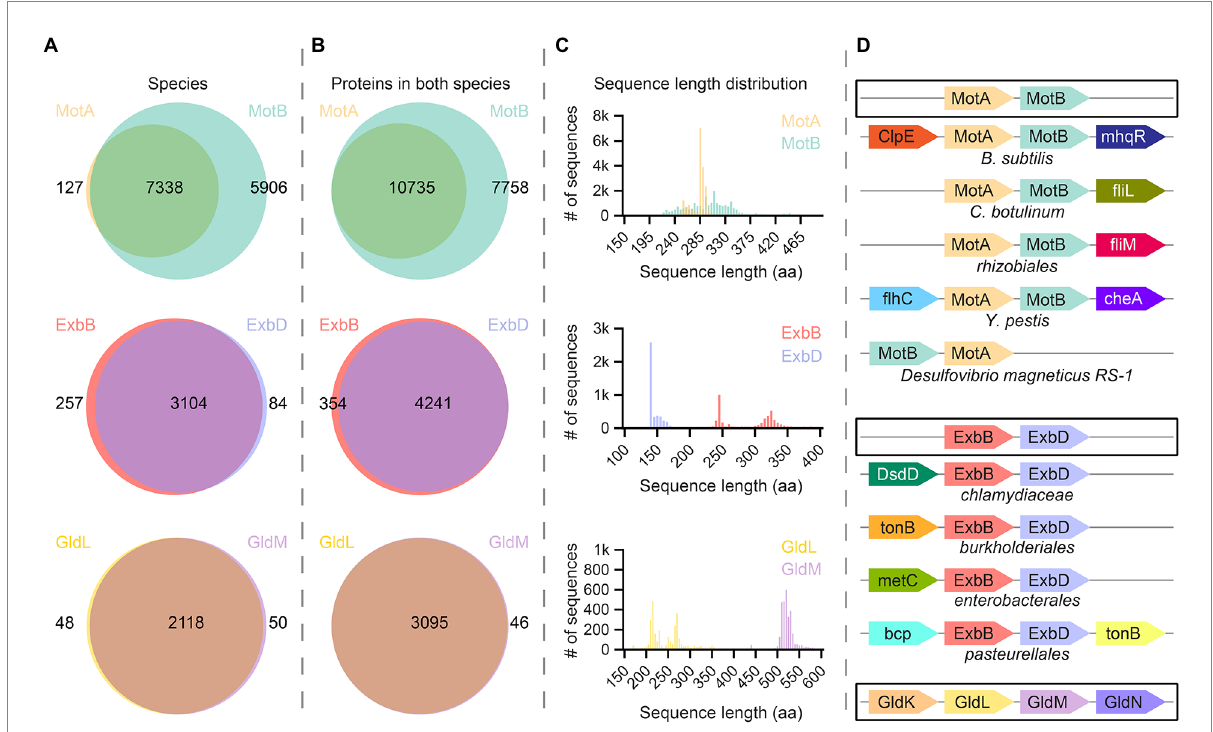
FIGURE 5 Bioinformatic analysis of bacterial proteins in the MotA/MotB family. (A) UniProt database were systematically screened for species that contain the MotA, MotB, ExbB, ExbD, GldL, or GldM proteins. In most cases, species contain annotations for both the transmembrane-barrel component and the rotational-axis component of a protein pair. (B) We analyzed the number of proteins in species that contain two elements of molecular motors [overlapping in (A) ]. The number of annotated ExbB/D and GldL/M proteins is rather similar, whereas there are many more annotations for MotB than for MotA. (C) Sequence length distribution of all proteins described in (B) . Each histogram bin represents 5 amino acids. Proteins from the MotA family show a narrow two-peak distribution, whereas proteins from MotB family show more divergent lengths. ExbB and GldL proteins come in two length classes with normal distributions, while the size distribution of ExbD and GldM proteins is rather uniform. (C) The most prominent cases of synteny (co-localization) of genes encoding molecular machines. A typical scenario is highlighted by black rectangles. Functionally relevant or widespread genomic neighbors are shown. MotA-MotB synteny is broken only in the case of Desulfovibrio magneticus RS-1